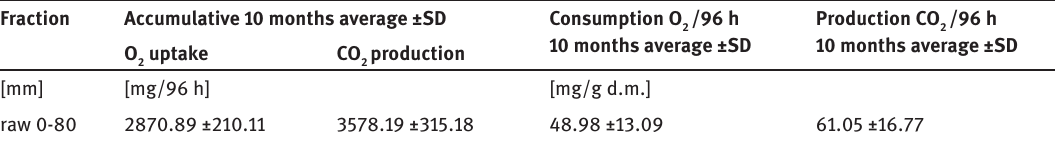
Table 3: The 10 months average biological activity of the untreated 0-80 mm fraction of the MSW before processing in the MBT plant.